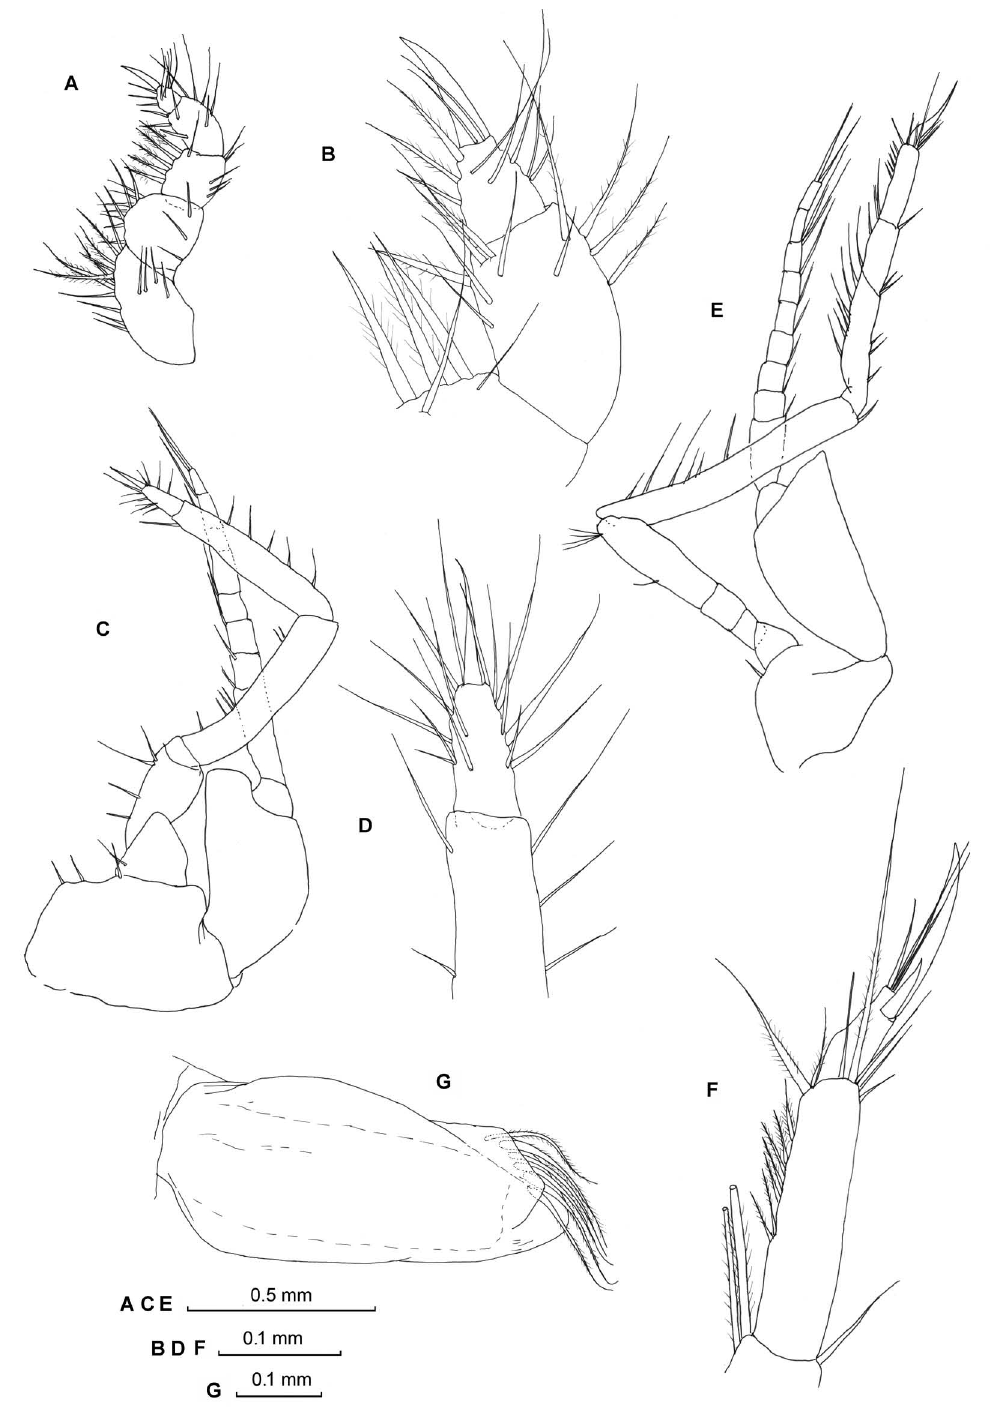
Fig . 3. – Dactylamblyops corberai n. sp.: A, endopod of 1st thoracopod; B, chela of 1st endopod thoracopod; C, 2nd thoracopod; D, chela of 2nd thoracopod endopod; E, 7th thoracopod; F, chela of 7th thoracopod; G, male genital organ; A-D, holotype, mature male; E-G, paratype, mature male TL 7.0